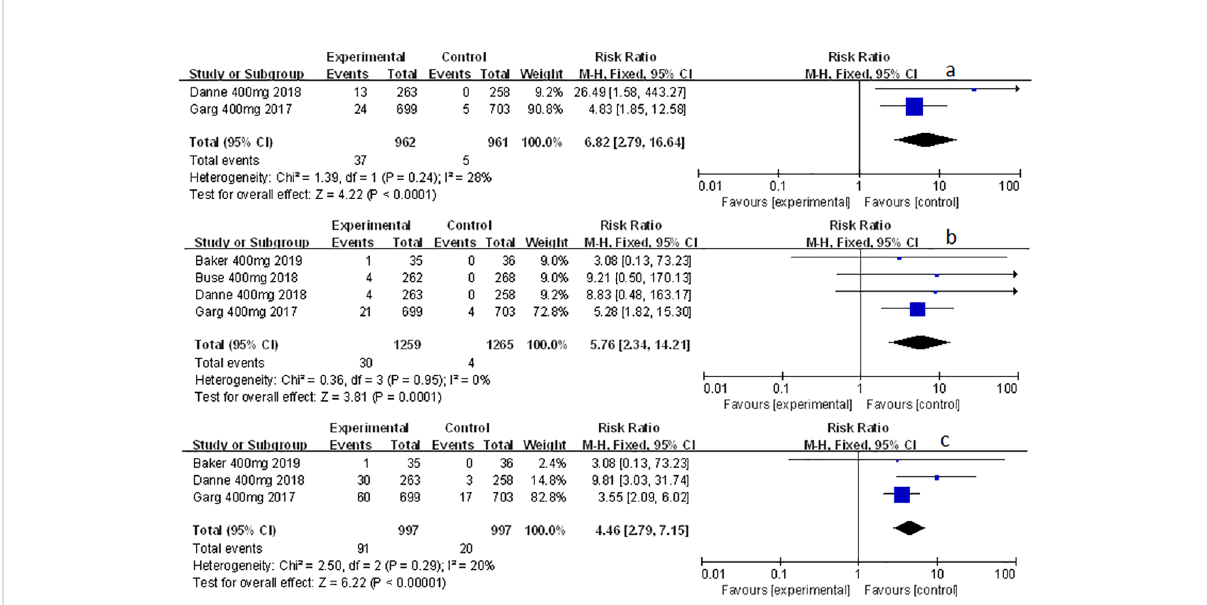
FIGURE 4 Forest plot of related to acidosis events in the subgroup of sotagli fl ozin 400mg versus the control group in T1D. (A) The adverse events of severe acidosis-related adverse events in T1D. (B) The adverse events of positively adjudicated DKA in T1D. (C) The acidosis-related adverse events in T1D.